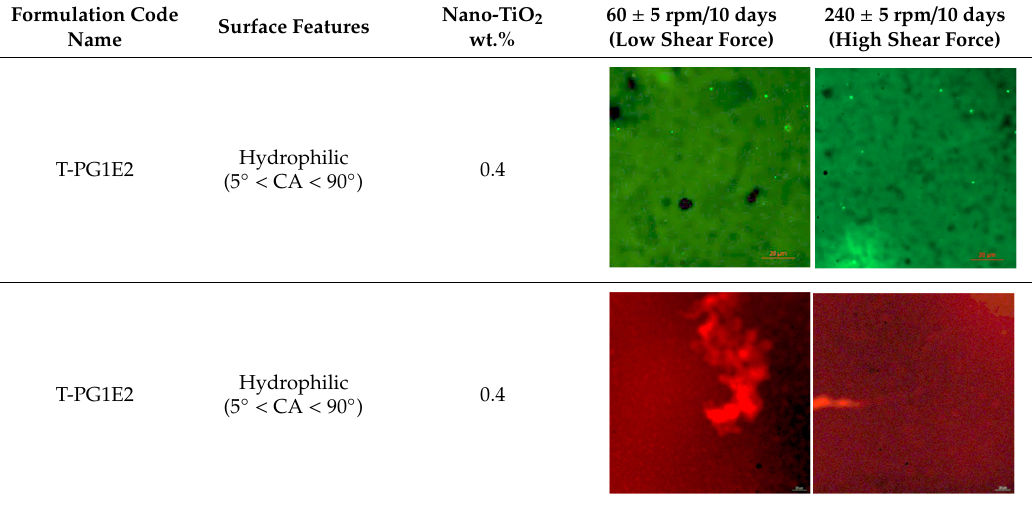
Table 4. Live/dead microscopy of control group indicating the effect from nano-TiO 2 Table 4. Live / dead microscopy of control group indicating the e ff ect from nano-TiO 2 wt.%. Formulation